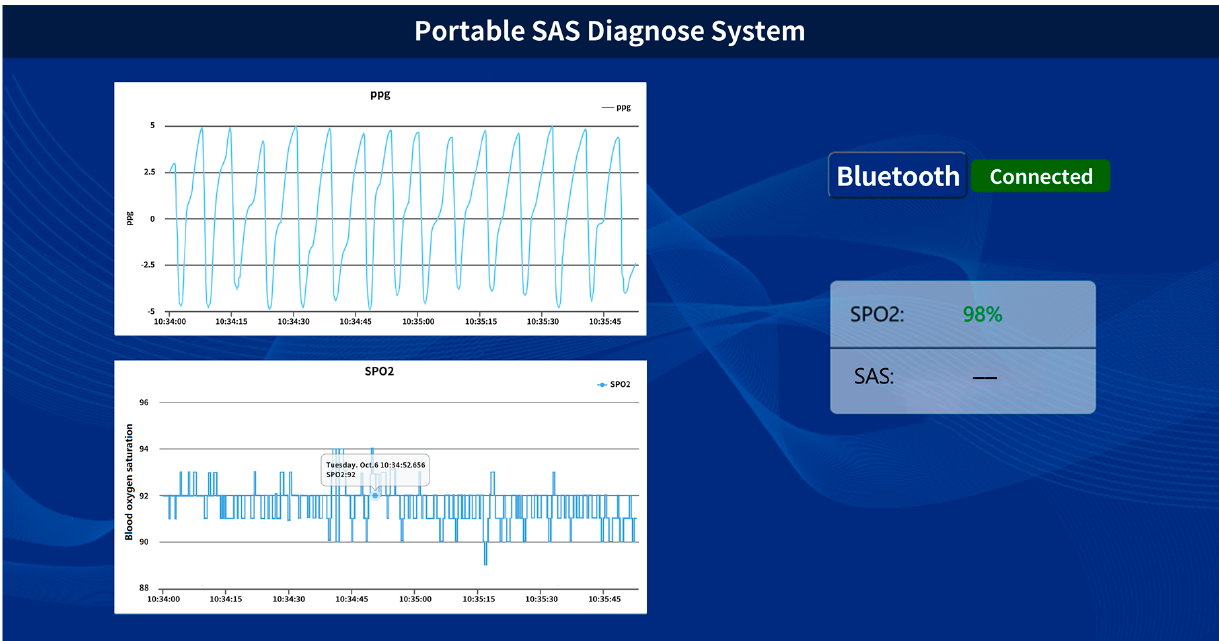
Figure 5. App graphics user interface developed to receive the PPG signal from the smart ring during sleep.